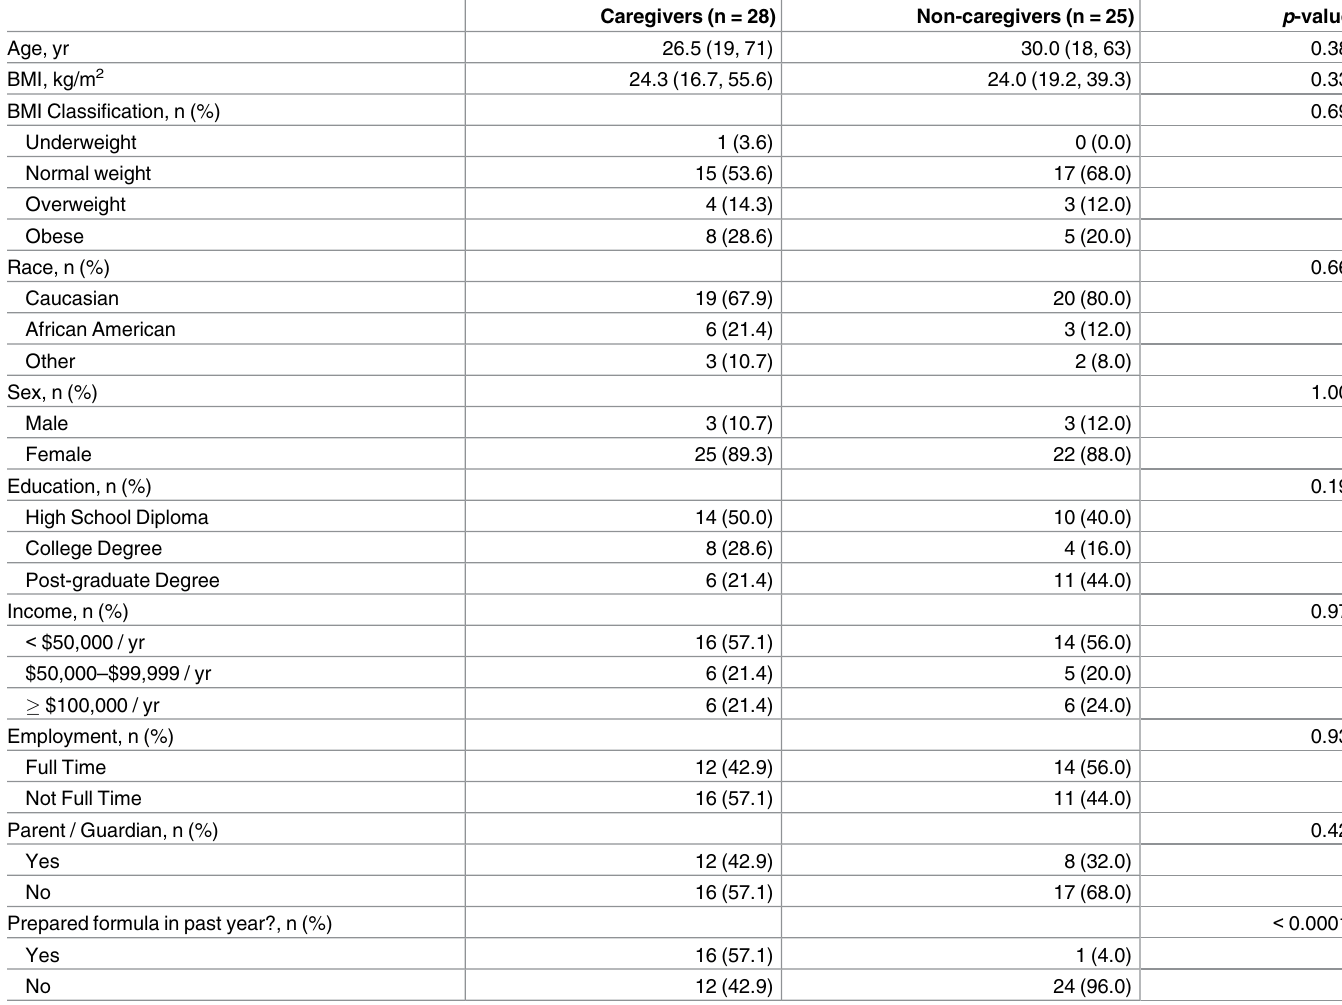
Table 1. Characteristics of Study Participants.